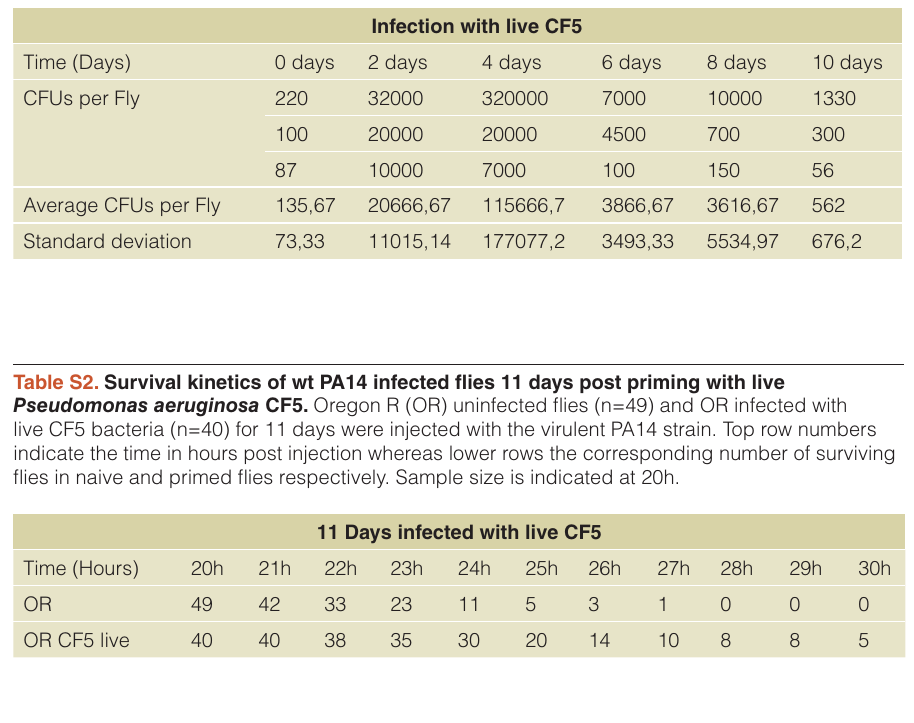
Table S1. Persistence of Pseudomonas aeruginosa CF5 in the fly. Infected flies were ground and plated, 3 individuals per replicate, at days 0, 2, 4, 6, 8 and 10 post infection where the colony forming units (CFU) were measured and calculated per fly. The experiment was performed in triplicates where the average CFU numbers were plotted with the corresponding standard deviation.